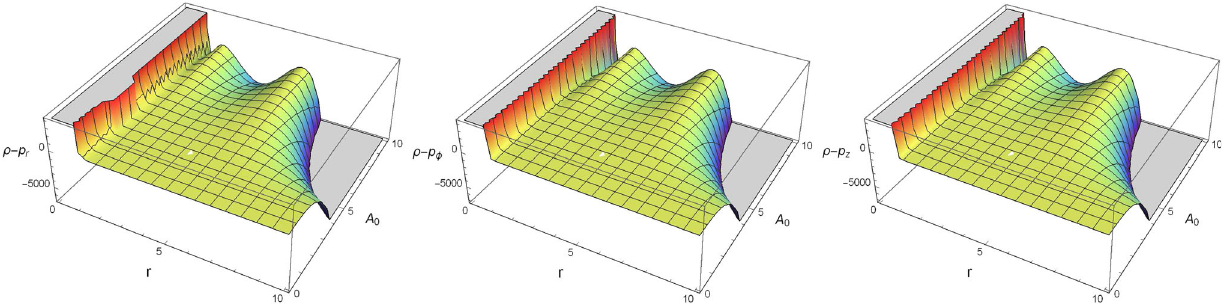
Fig. 12 This panel shows the variation of (ρ − p r ) (MeV/fm 3 ) , (ρ − p φ ) (MeV/fm 3 ) and (ρ − p z ) (MeV/fm 3 ) w.r.t r (km) with n = m = 1 along with α = − 0 . 01. CASE (C)